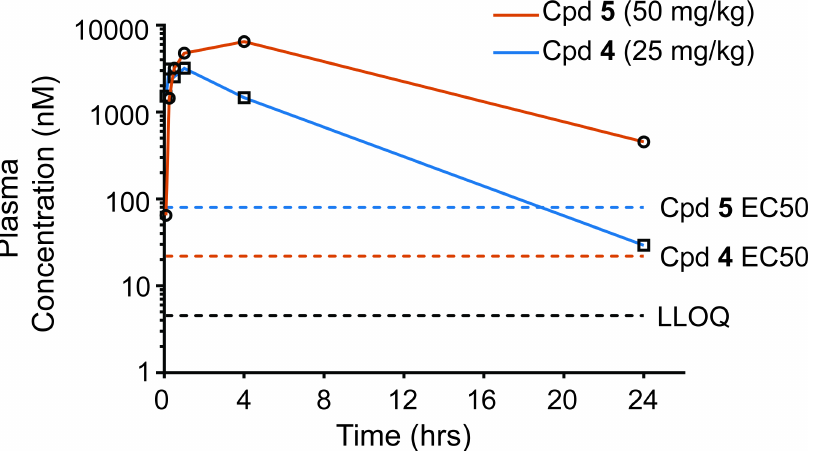
Fig 4. In vivo pharmacokinetic profiling of compounds 4 and 5. Murine pharmacokinetic studies for compound 4 and 5 delivered per os (25 mg/kg and 50 mg/kg respectively).